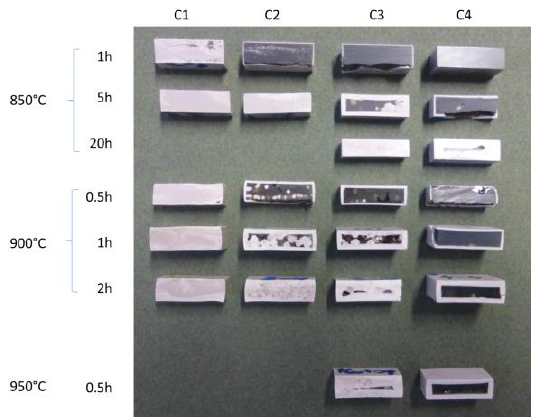
Figure 7. Cross-sections of the samples of parent glasses C1, C2, C3 and C4 heat treated at 850 °C, 900 °C and 950 °C for various holding times.